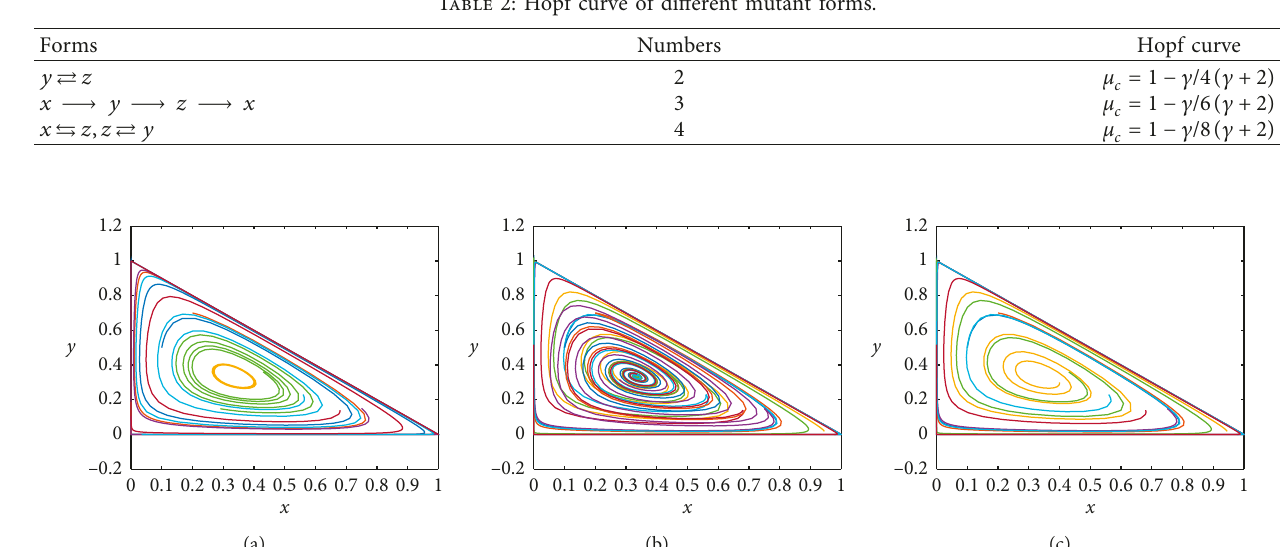
Figure 3: The interior equilibrium’s changing situation with different c . (a) When c � 1, the limit cycle occurs around the interior equilibrium. (b) When c � 1 . 5, the interior equilibrium is stable. (c) When c � 0 . 8, the interior equilibrium is unstable.